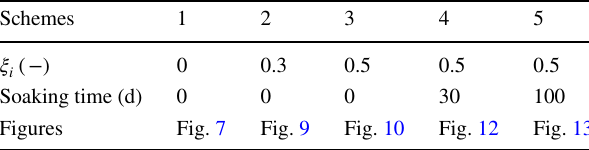
Table 5 Different injection and soaking schemes for the parent well